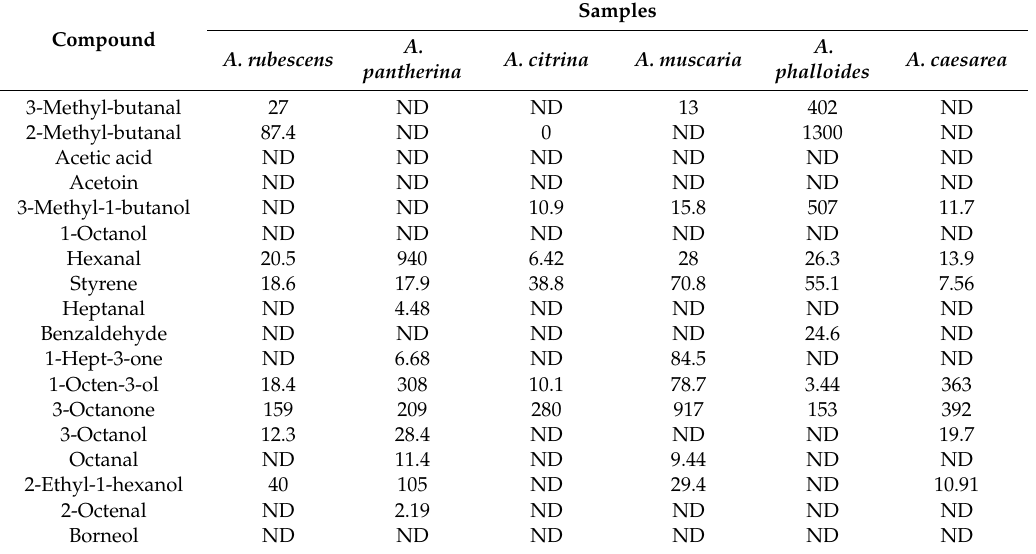
Table 6. Volatile compounds identified by gas chromatography–mass spectrometry (GC–MS) in the mushroom species